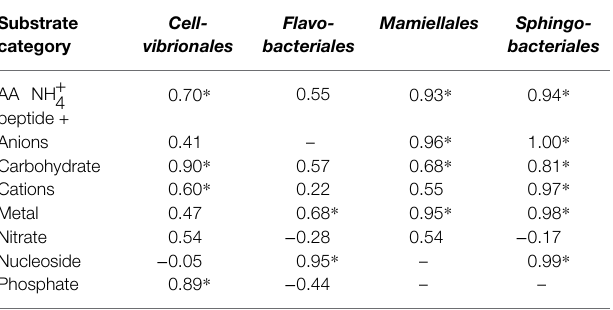
TABLE 3 | Correlation between metagenome (MG) abundance of transporter clusters and metatranscriptomic (MT) expression of transporter clusters at four sampling dates, see Section “Materials and